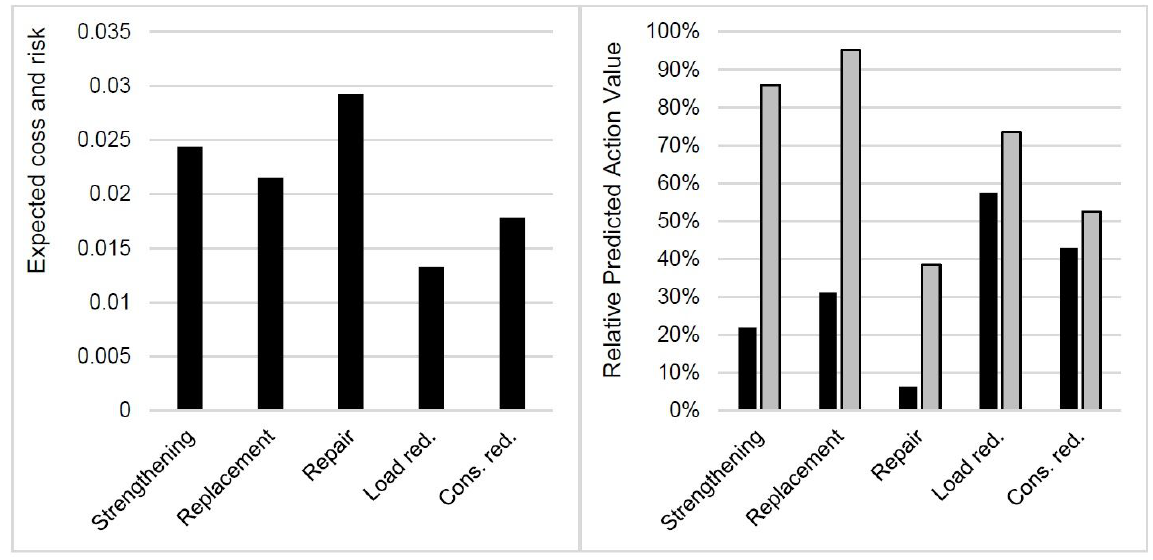
Figure 2. System performance normalised relative action values without the action costs (left side, grey) and with action costs (left side, black) and total expected action cost and risks